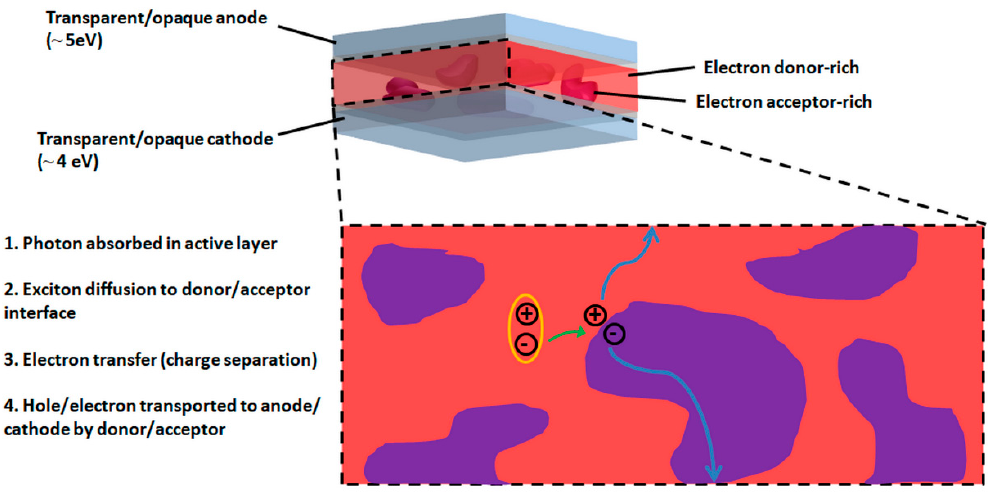
Figure 1. Schematic representation of bulk heterojunction organic solar cells (OSCs). Values in brackets under the electrodes correspond to the typical work functions of anodes and cathodes employed in OSCs.